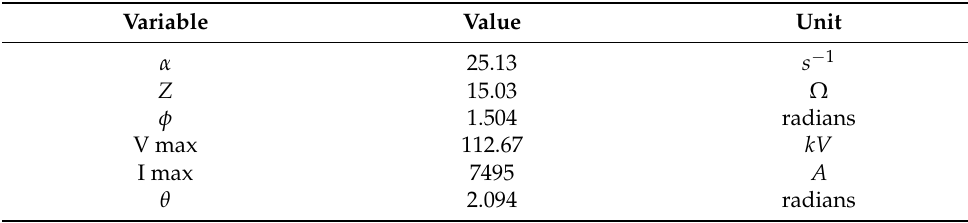
Table 5. Variables for the R = 1 Ω and X L = 15 Ω